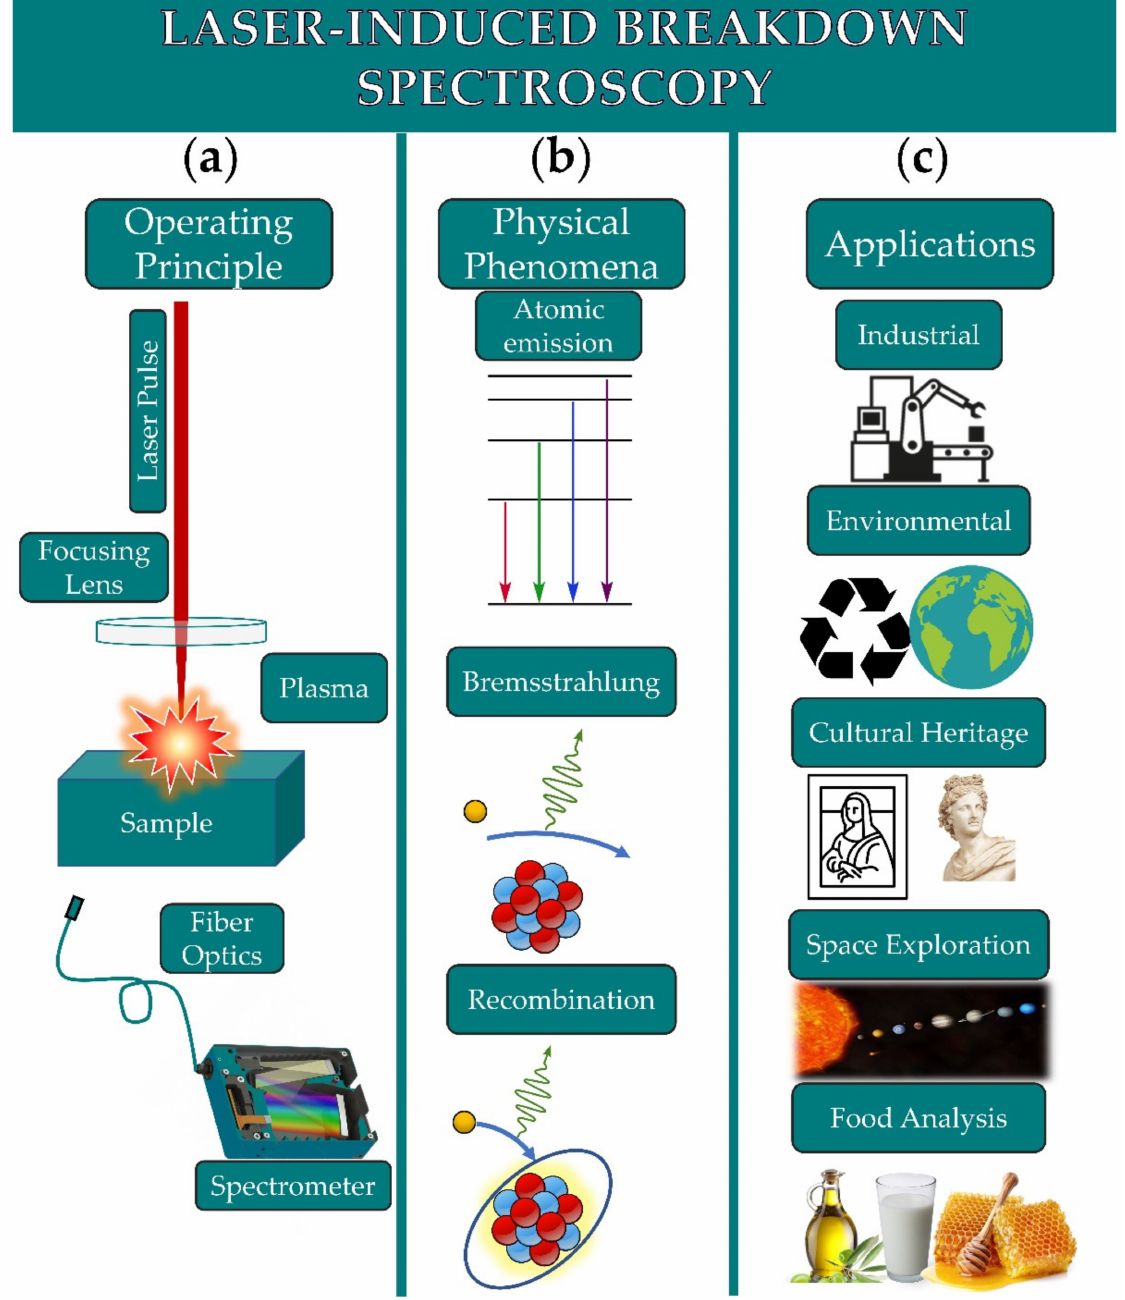
Figure 1. ( a ) Schematic of a LIBS setup. ( b ) Radiative processes occurring in the plasma (atomic emissions, Bremsstrahlung, and recombination). ( c ) Typical applications of